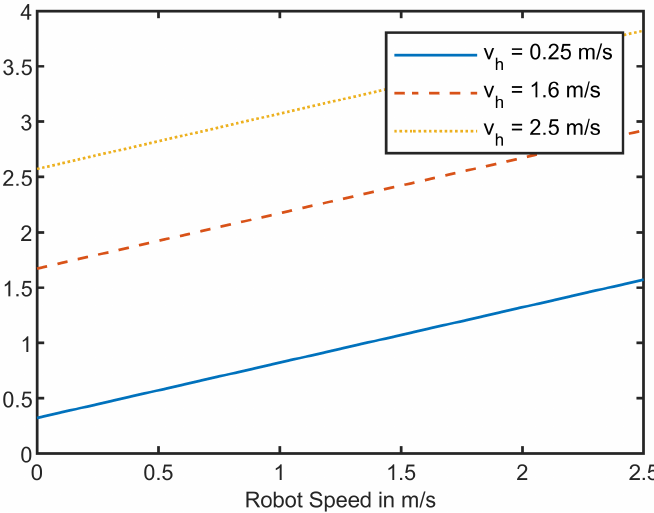
Figure 3. Protective Separation Distances for robot speeds between 0 m/s and 2.5 m/s and operator speeds of 0.25 m/s, 1.6 m/s, and 2.5